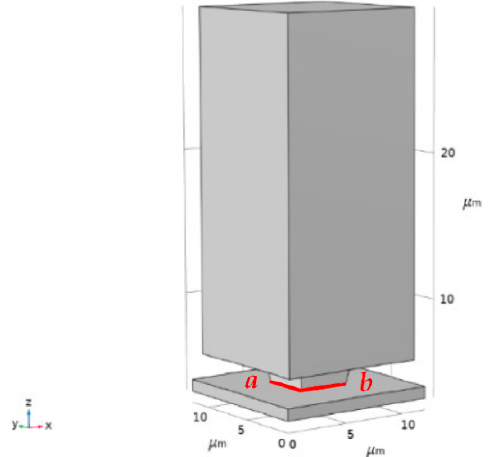
Figure 2. Geometry of the stopper; dimensions a and b at the base of the columnar structure can vary and are explicitly reported in Table